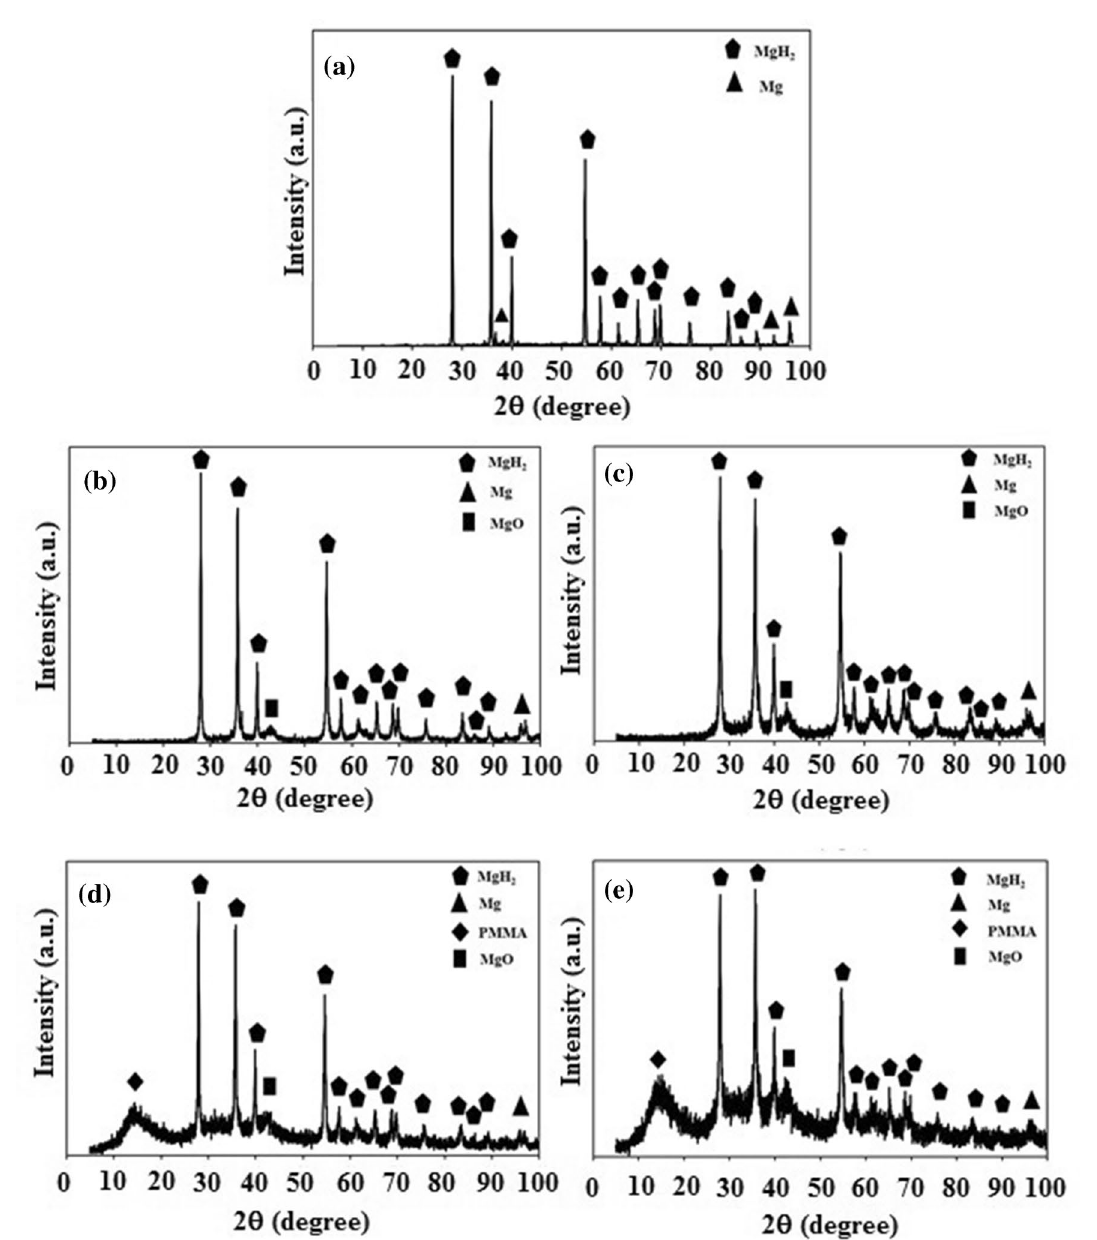
Fig. 1 XRD patterns of a MNB (as received MgH 2 ), b M5, c M20, d M5P and e M20P samples (see Table 1 for